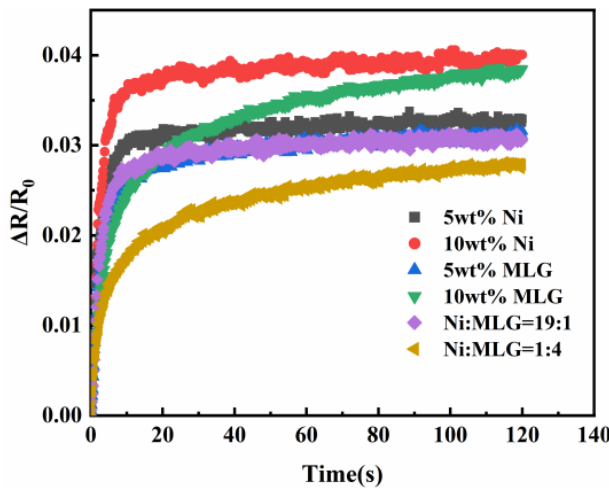
Figure 10. A comparison of the relative optimal resistance to creep for several affecting variables.